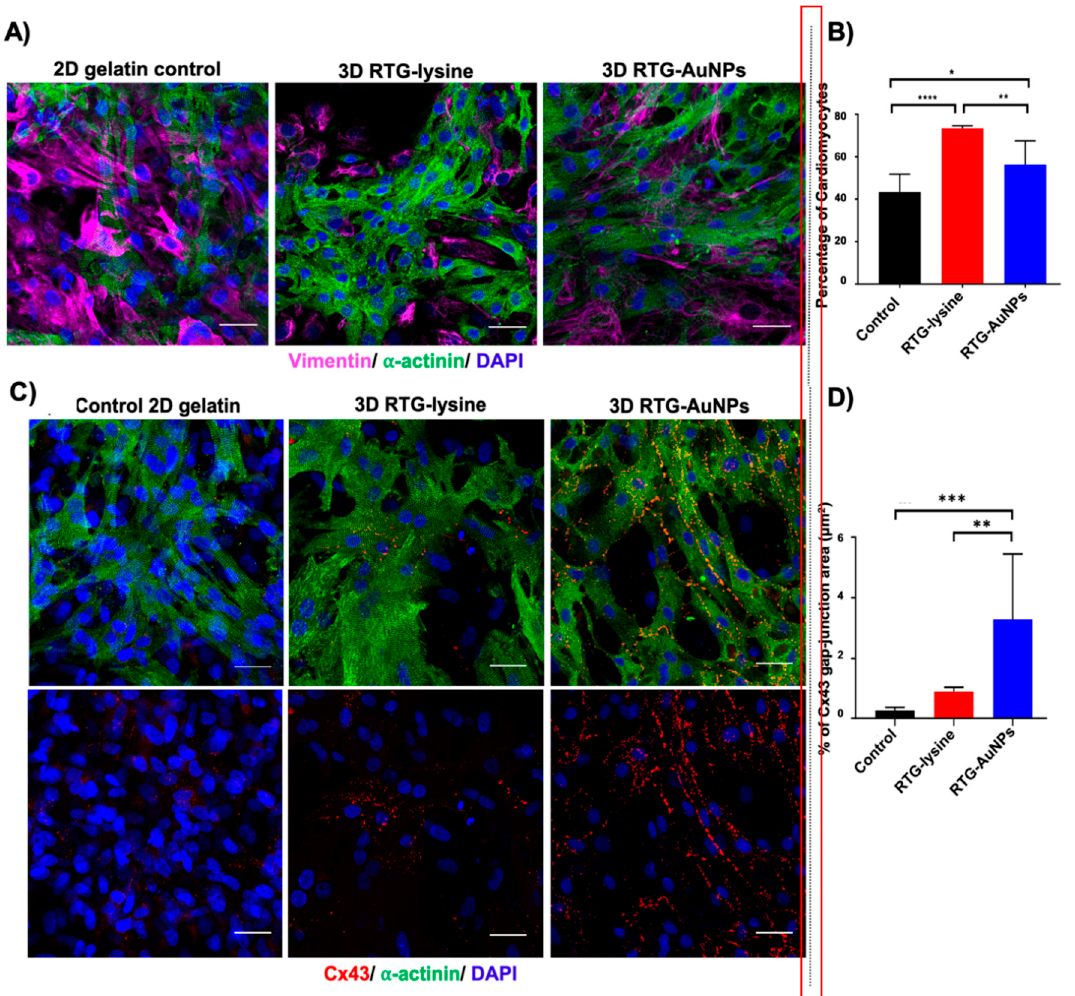
Figure 3. Upper panel: Immunocytochemistry labeling of NRVMs and cardiac fibroblasts (CFs) cultured in 2D and 3D systems for 21 days. ( A ) Antibody staining against α -actinin (green) and vimentin (pink) label NRVMs and CFs, respectively, with nuclei labeled using DAPI (blue). ( B ) Quantification of immunocytochemistry staining against α -actinin indicates percentage of cells likely to be NRVMs, showing both 3D systems to contain a greater percentage of NRVMs than the 2D gelatin control. Scale bar 40 µ m. p values: * < 0.023, ** < 0.0017 and **** < 0.0001. Data are presented as mean ± S.D. Lower panel: Immunocytochemistry labeling of gap junctions in NRVMs cultured in 2D and 3D systems for 21 days. ( C ) Antibody staining against connexin 43 (Cx43) (red) and α -actinin (green), with nuclei labeled using DAPI (blue). ( D ) Quantification of immunocytochemistry staining against Cx43 to indicate surface area of NRVMs positive for this gap junction protein, showing the RTG-AuNPs system to contain the largest Cx43-positive area. Scale bar: 40 µ m. p values: ** < 0.0021 and *** < 0.0002. Data are presented as mean ± S.D. Reprinted with permission from [81] Copyright 2019 American Chemical